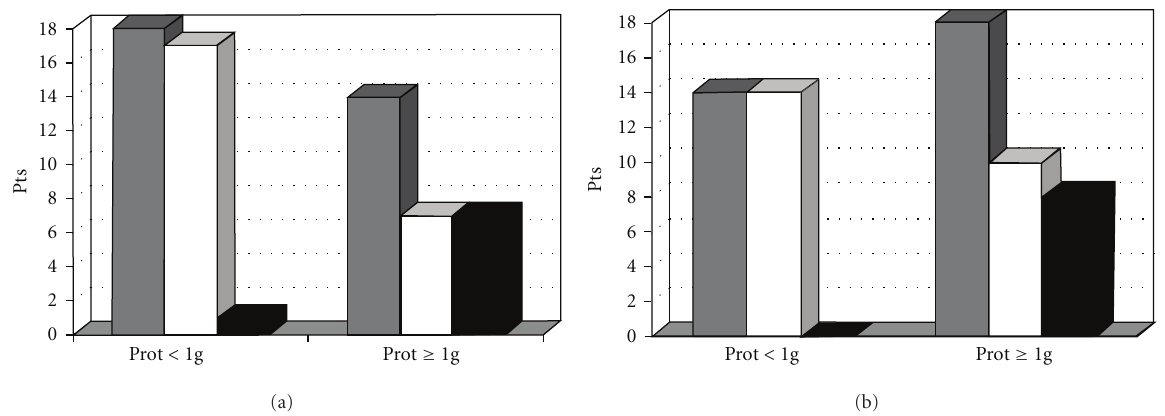
Figure 2: (a) Number of patients with proteinuria either less or ≥ 1g/day after 12 months of treatment (grey) and number of patients who either reached (black) or did not reach (white) ESRD after a mean follow up of 48 months [7] . (b) Number of patients with a time-average proteinuria either less or ≥ 1 g/day (grey), and number of patients who reached (black) or did not reach (white) ESRD after a mean follow up of 48 months